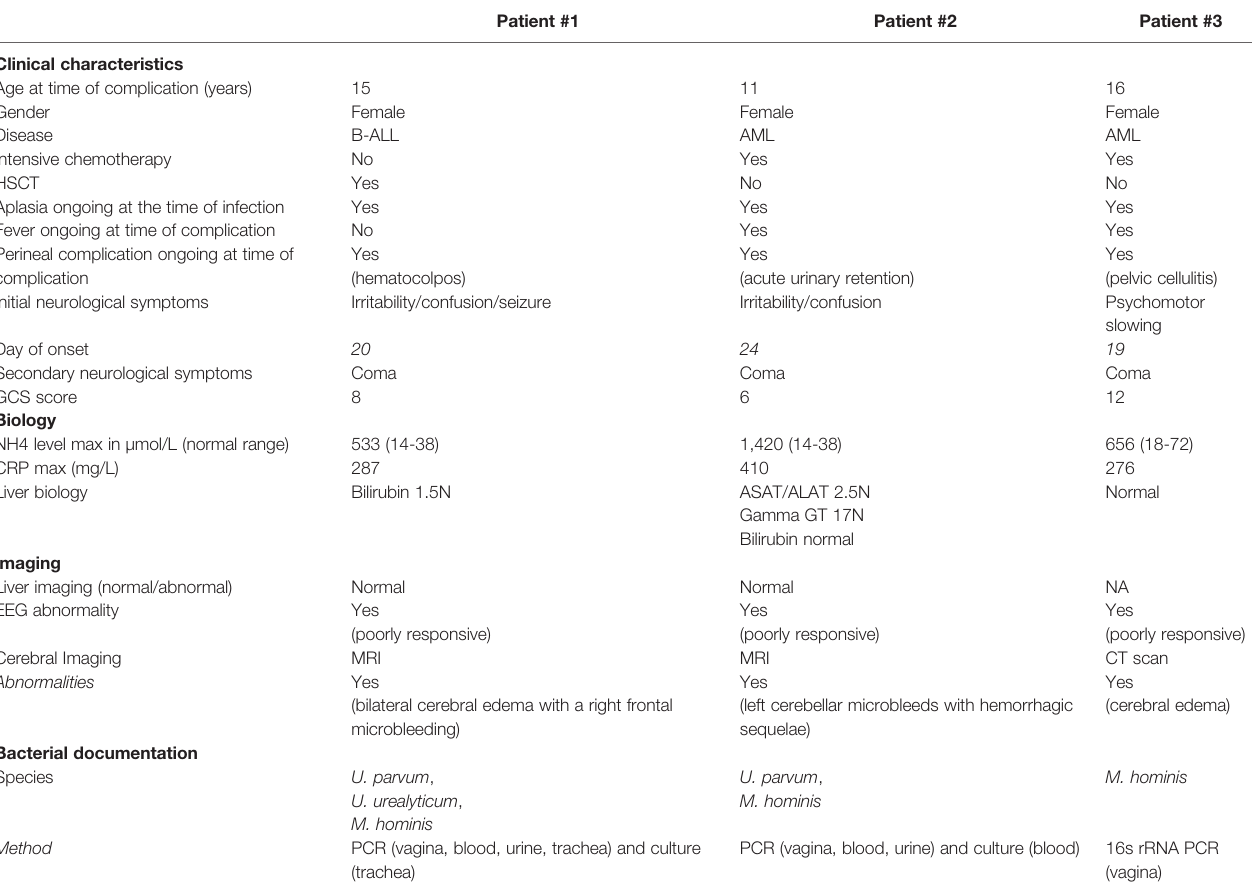
TABLE 1 | Clinical, biological, and imaging characteristics at onset of the three newly reported